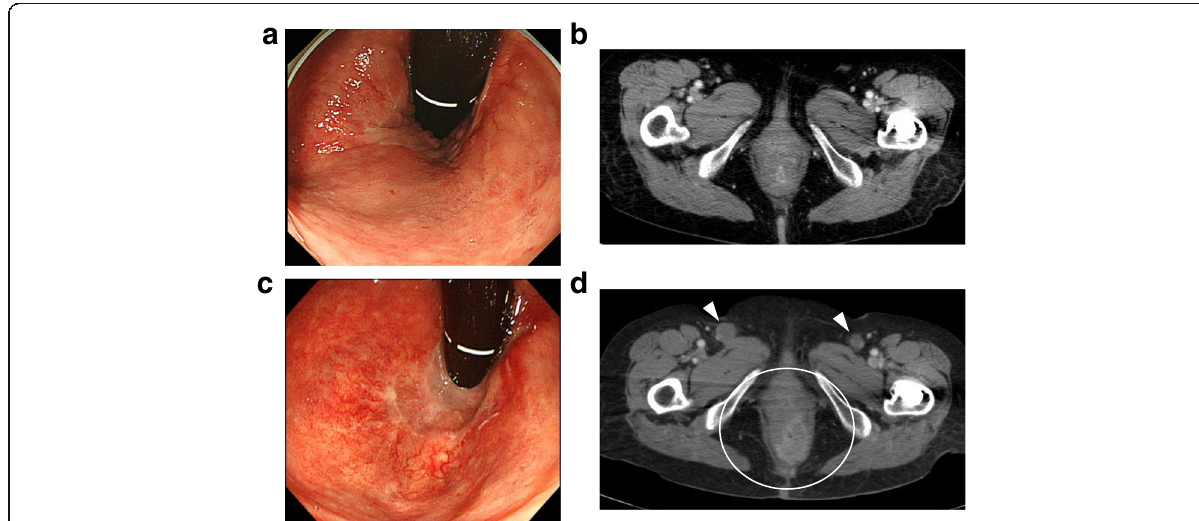
Fig. 3 No specific target lesions were observed by rectal endoscopy ( a ) and CT ( b ). Endoscopy showed that anorectal mucous membranes had become rough ( c ). CT revealed thickening of the anorectal wall (circle) and bilateral inguinal lymph node metastasis (arrow head) ( d